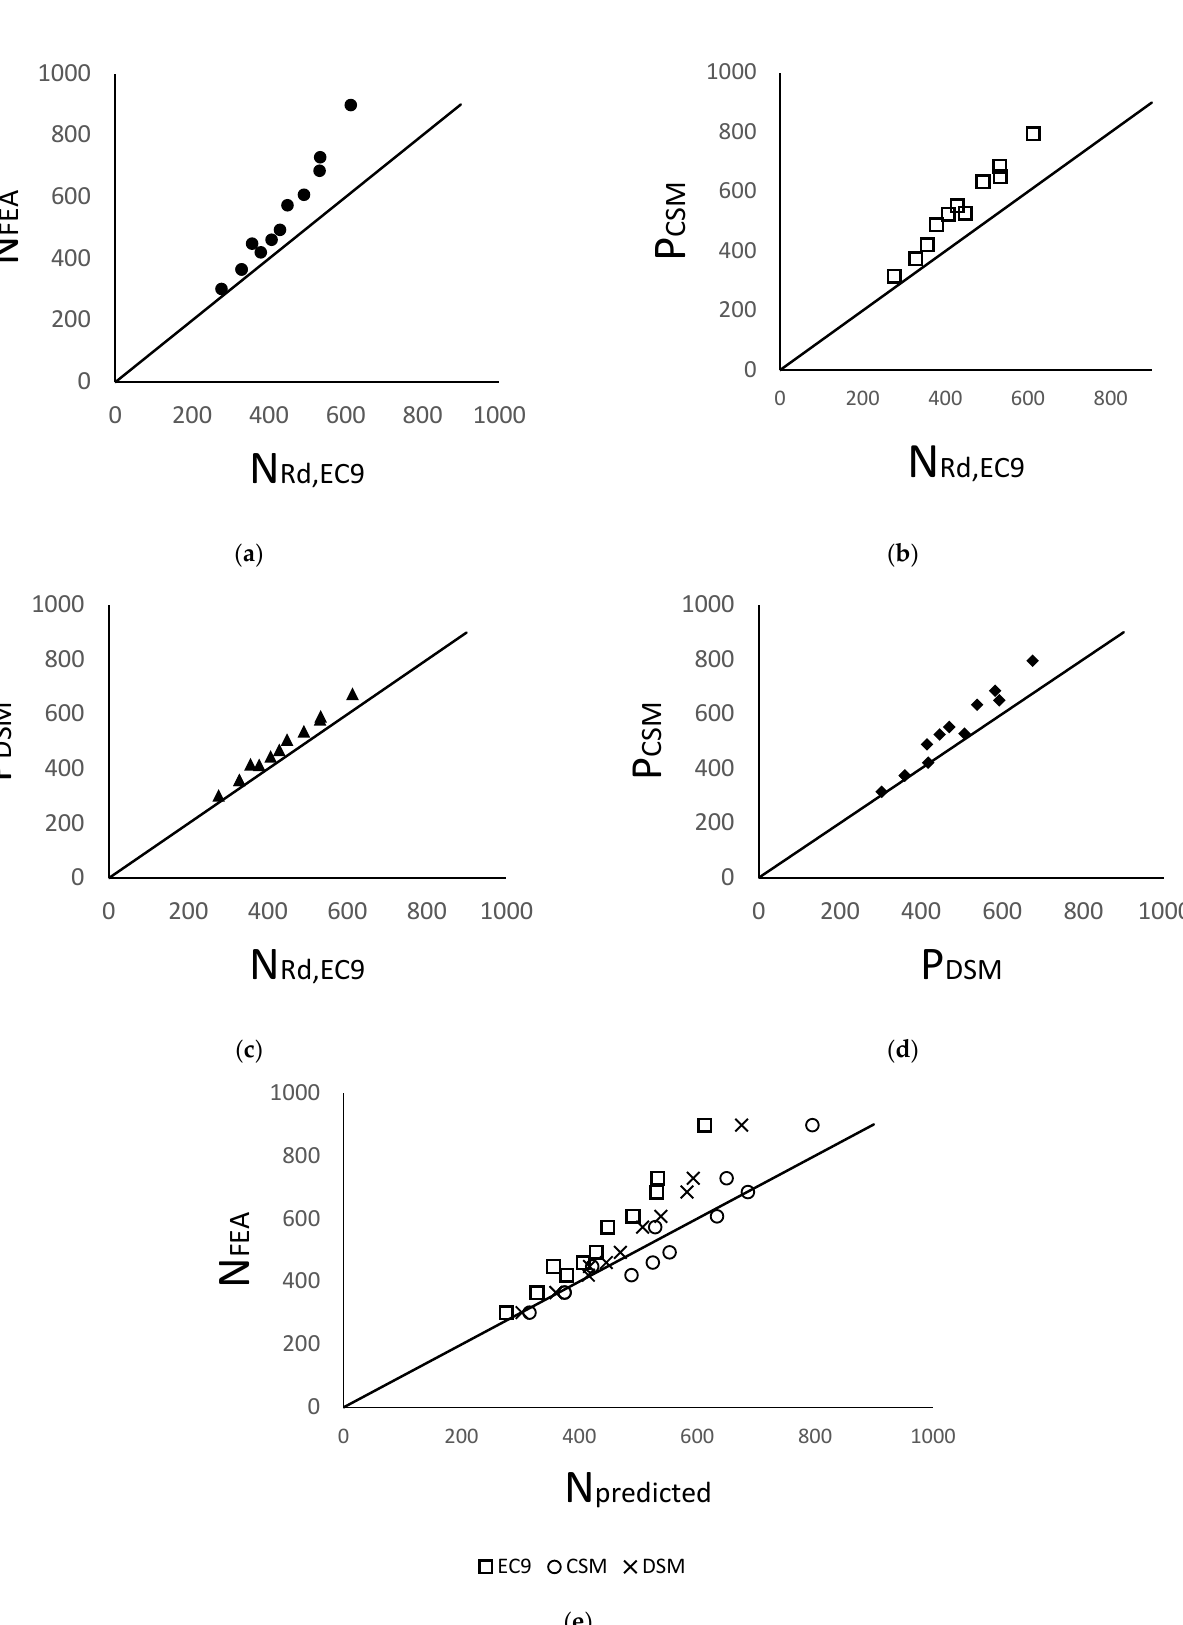
Figure 7. Stocky cross-sections: Comparison between the maximum compressive resistances obtained from ( a ) FEA vs. EC9; ( b ) CSM vs. EC9; ( c ) DSM vs. EC9; ( d ) CSM vs. DSM; ( e ) FEA-obtained values vs. predictions from different methods, EC9, CSM, and DSM.